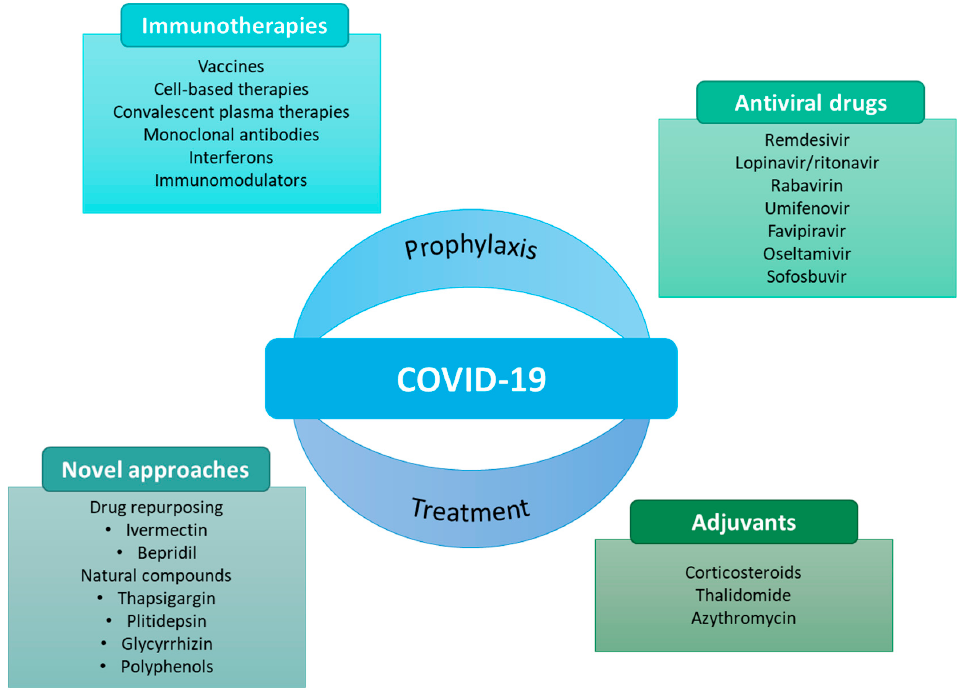
Figure 1. Some examples of prophylactic and therapeutic approaches against COVID-19 [12].